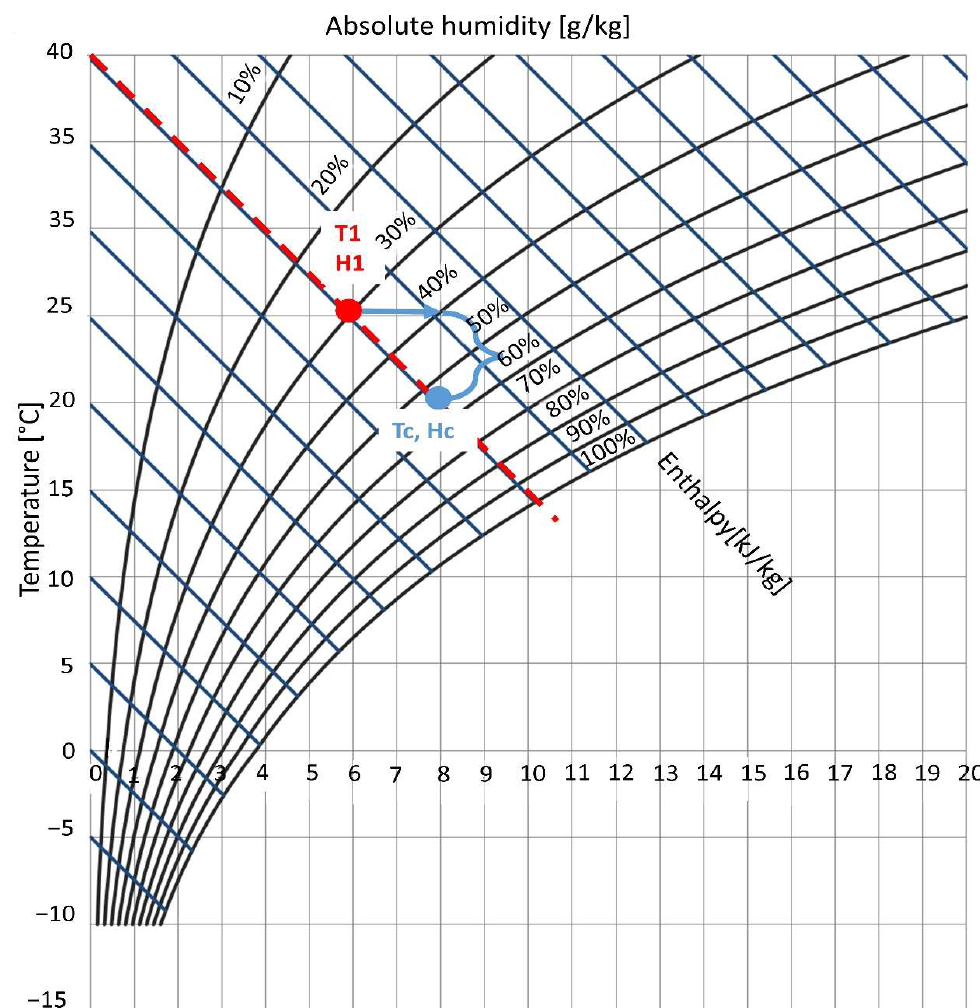
Figure 3. Part of the Molliar diagram illustrating the temperature after evapotranspiration under an adiabatic process. The curved lines describe relative humidity as a percentage; the scale ranges from 0% up to the saturation line of 100% relative humidity. The diagonal lines describe the specific enthalpy.